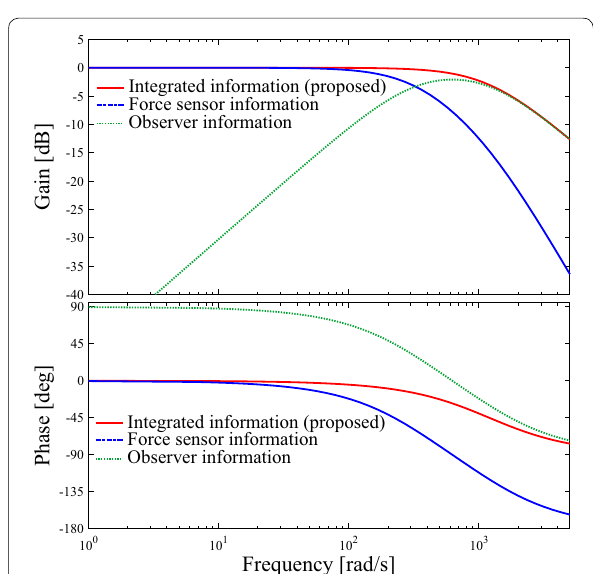
Fig. 3 Bode diagram of the external torque